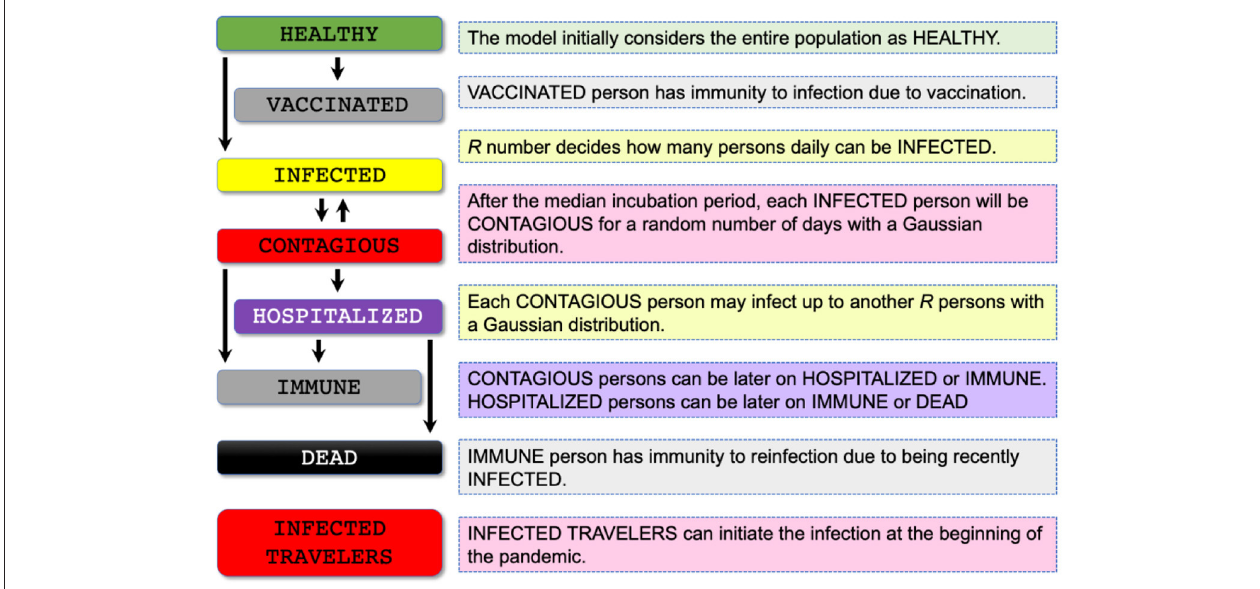
FIGURE 3 | Proposed population clustering algorithm for assigning each individual in the population of concern to a stage of the COVID-19 infection timeline. The COVIDHunter model makes eight main clusters: HEALTHY, VACCINATED, INFECTED, CONTAGIOUS, HOSPITALIZED, IMMUNE, DEAD, and INFECTED